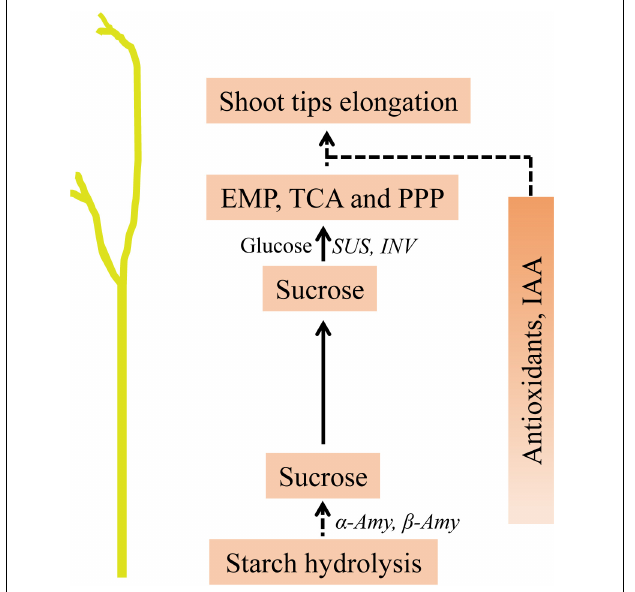
FIGURE 8 | Predicted model of metabolites in modulating the in vitro dodder shoot tips elongation. Starch degradation in the basal stems provided the main energy source. Sucrose, derived from starch hydrolysis, was transferred to the shoot tips, in which EMP, TCA and PPP activation directly provide energy and material basis for the following development. Meanwhile, the accumulations of antioxidants and hormone, such as IAA, might play essential roles in this